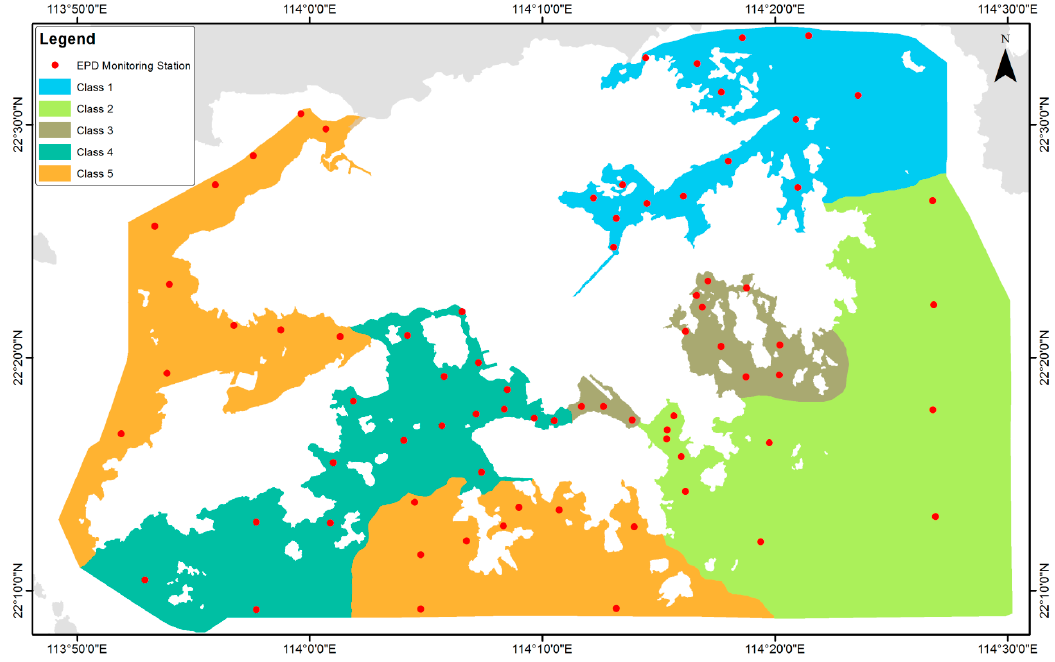
Figure 1. Hong Kong Environmental Protection Department’s (EPD) monitoring stations and water classes delineated by [11].